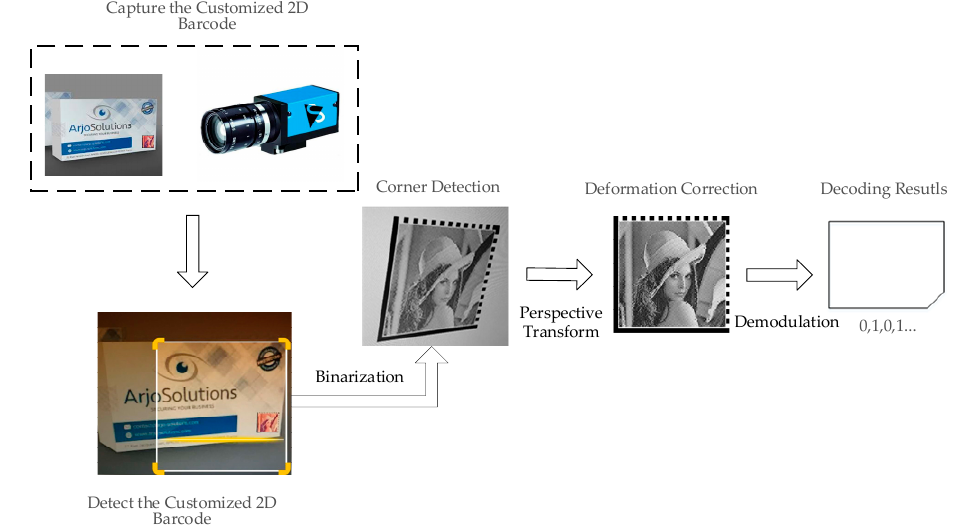
Figure 5. The recognition procedure of customized 2D barcodes sensing.